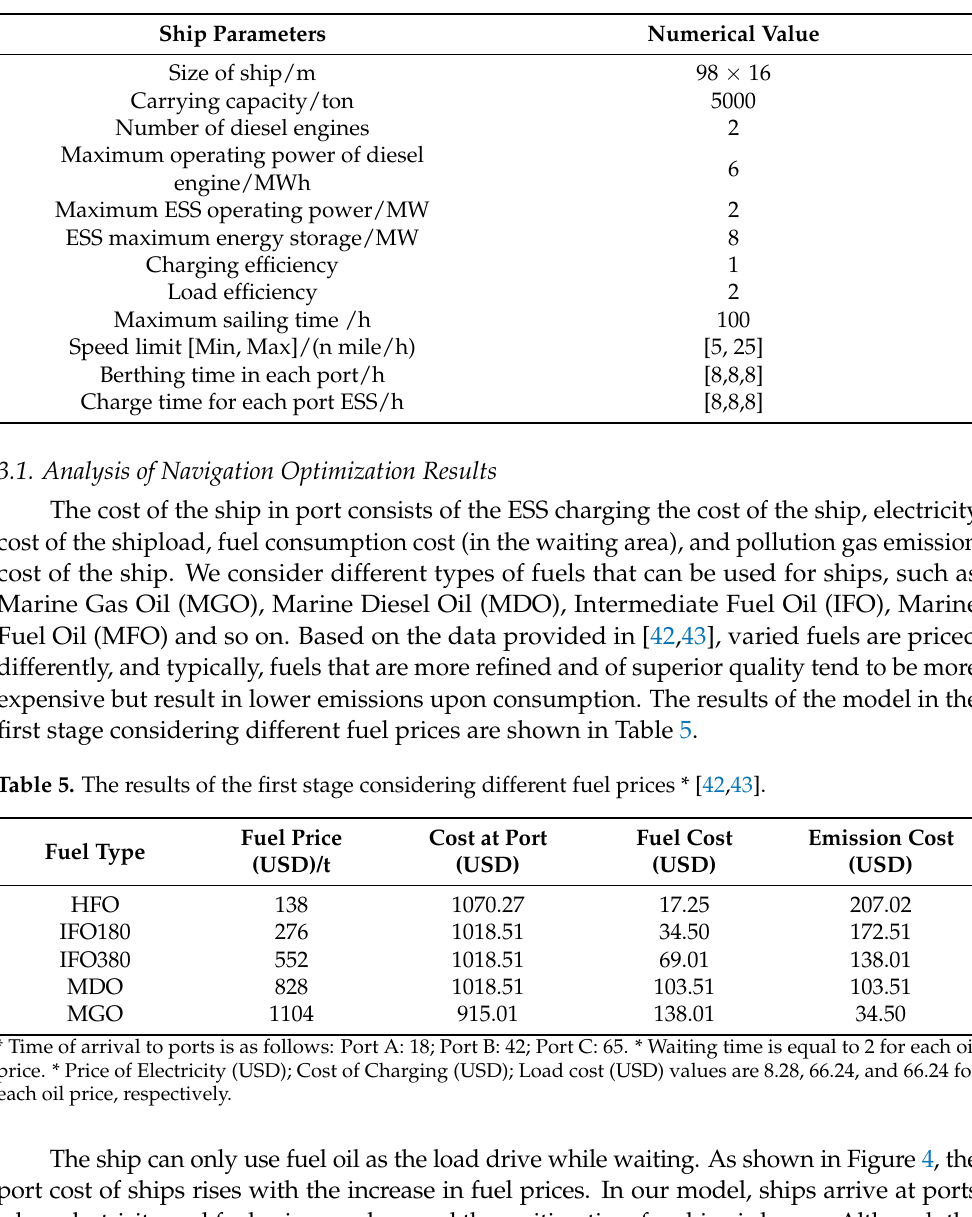
Table 4. Ship parameters [40].